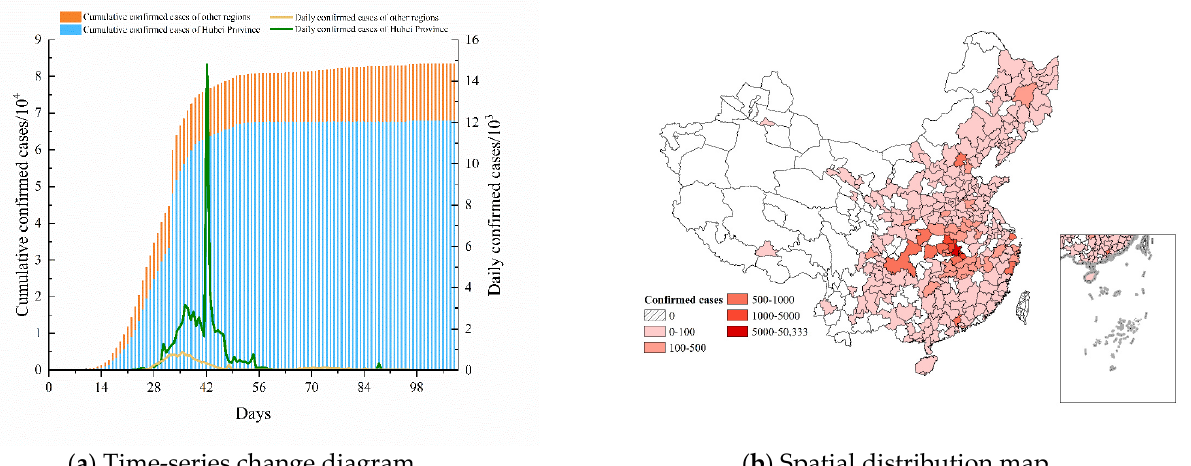
Figure 1. Spatial and temporal distribution of COVID-19 in China: ( a ) time-series change diagram; ( b ) spatial distribution map.